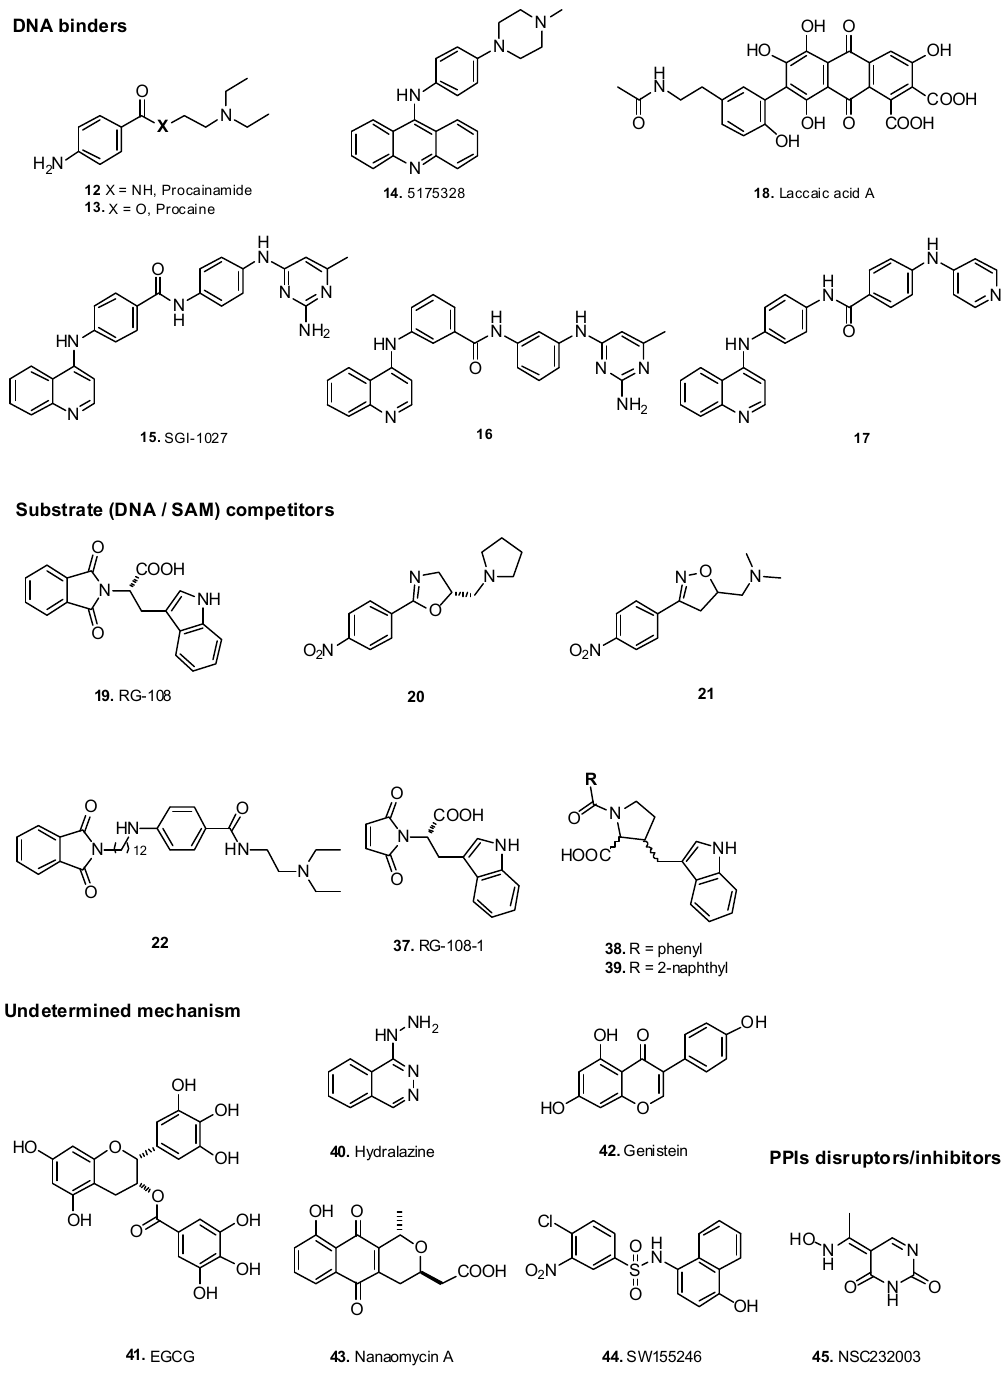
Figure 3. Structures of non ‐ nucleoside DNMT inhibitors.